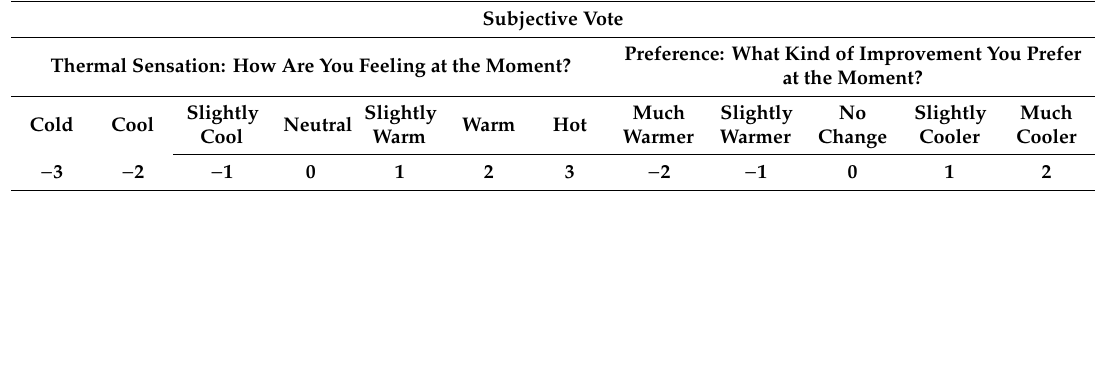
Table A3. Online Questionnaire during the educational workshops (Part 2).